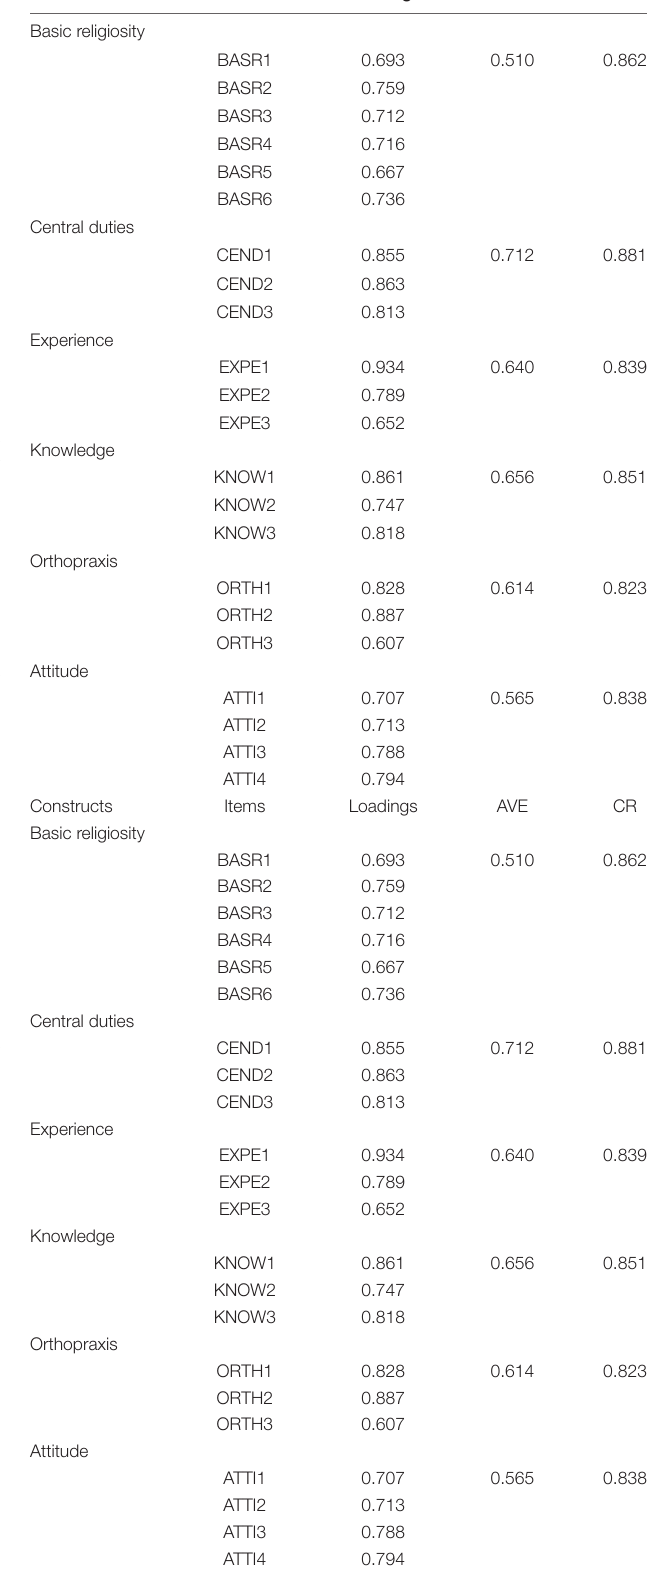
TABLE 2 | Measurement